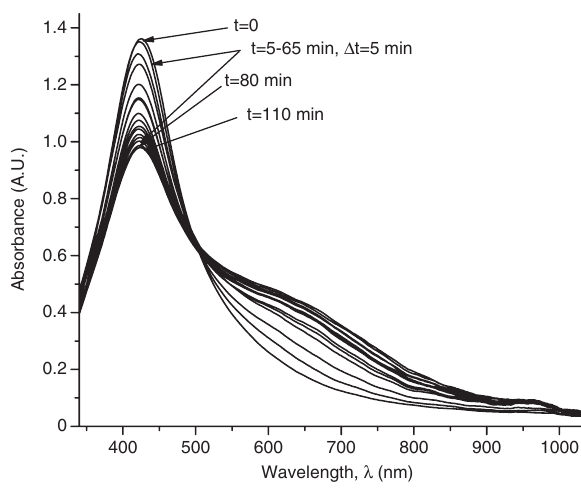
Figure 10 Absorption spectra of AgNPs-DNA before and after irradiation (5-min interval). [AgNPs] – 1.94 × 10 -4 mol/l (Ag 0 ), [DNA] – 1.6 × 10 -4 mol/l (P), [NaNO ] – 10 -2 mol/l. 3